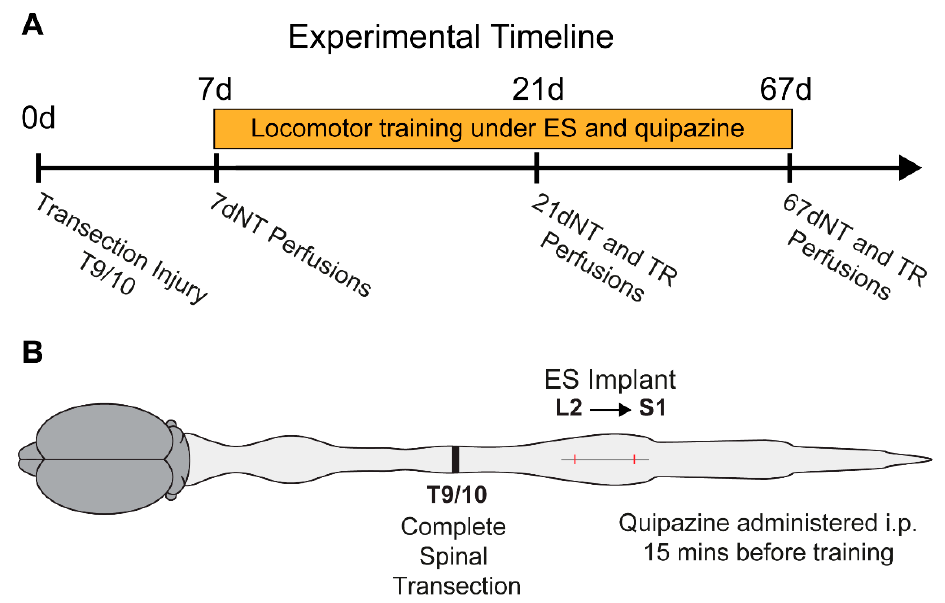
Figure 1. Schematic of the experimental timeline, injury, and electrode implantation. ( A ) Daily locomotor training under epidural electrical stimulation (L2 – S1, 40 Hz, 30 min/day) and quipazine (i.p., 0.3 mg/kg) started one week following a transection injury. Different groups were transcardially perfused at 7, 21, or 67 days post-injury. ( B ) Schematic of the location of the complete transection and implantation of epidural electrodes. 7dNT = 7 days, non-trained; 21dNT = 21 days, non-trained; TR = trained; 67dNT = 67 days, trained; 67dNT = 67 days, non-trained.